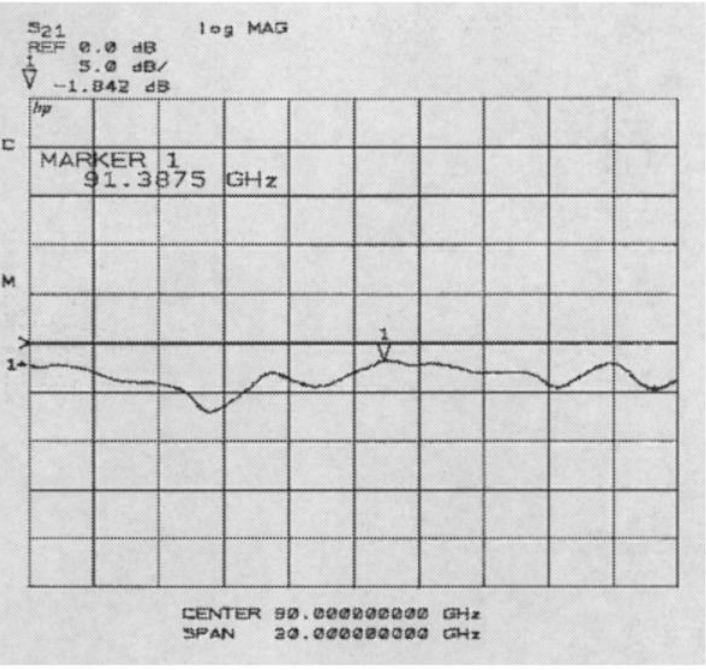
FIGURE 9 Frequency evolution of the transmission coefficient of the micromachined coplanar transmission line including the bend discontinuity between port I and III or II and IV.